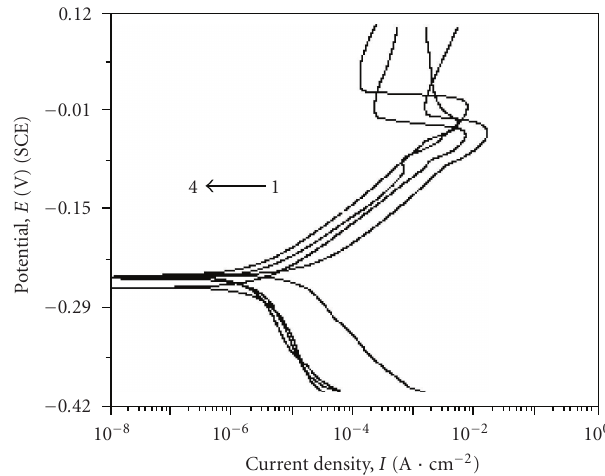
Figure 1: Polarization plots of copper in 0.5-M HCl with and without di ff erent concentrations of ATA, without ATA, (1); with 0.1-mM ATA; (2); with 1-mM ATA, (3); with 10-mM ATA,